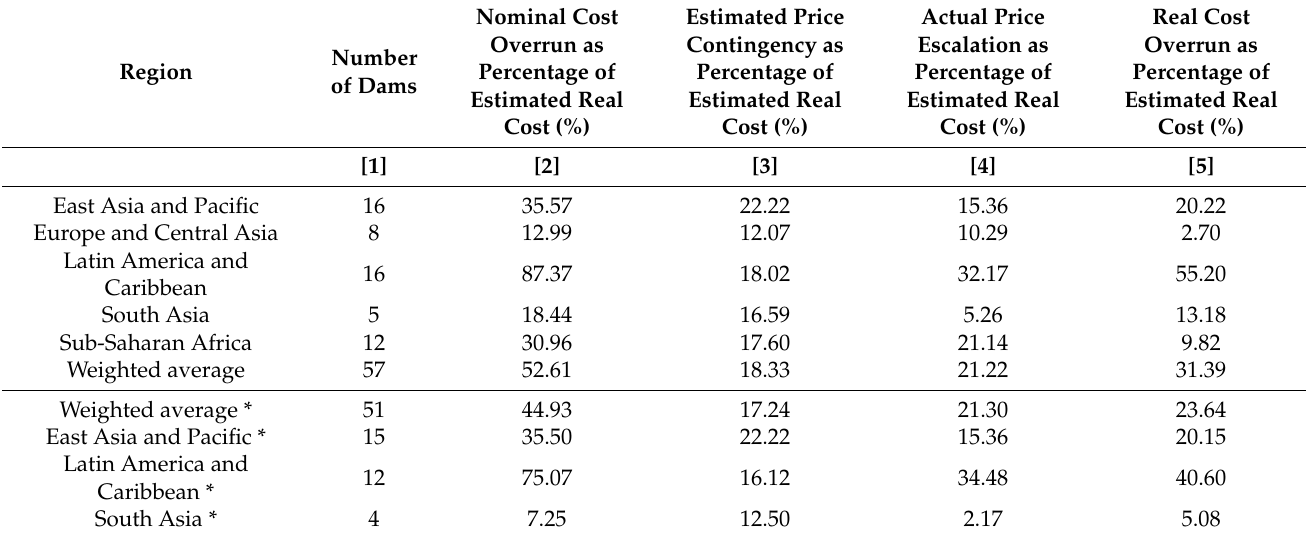
Table 4. Estimated average cost overruns across